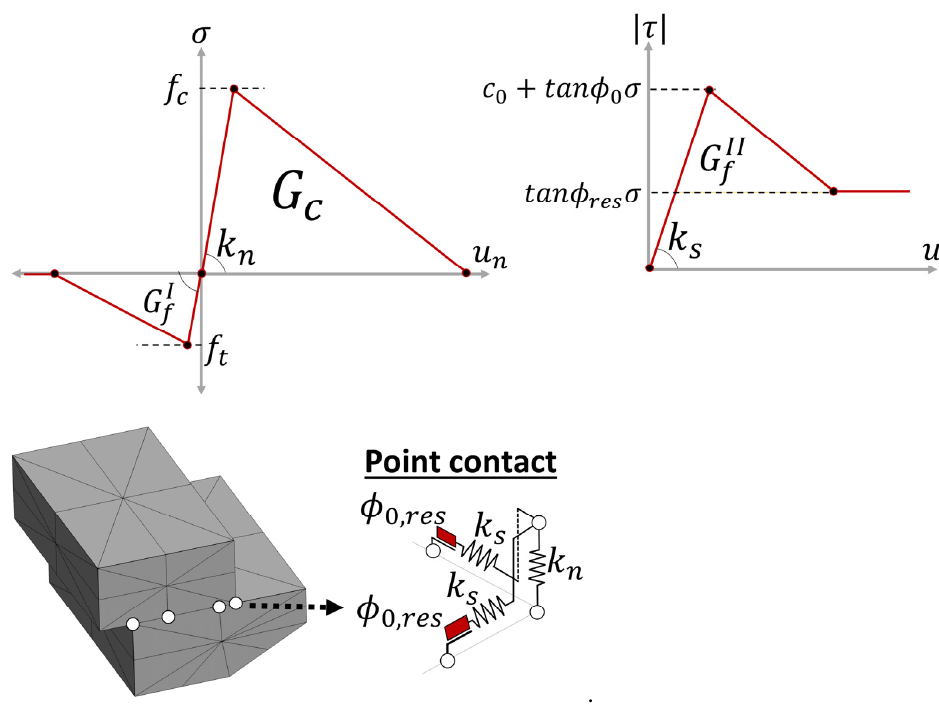
Figure 2. Representation of the contact models ( top ) and point-contact approach ( bottom